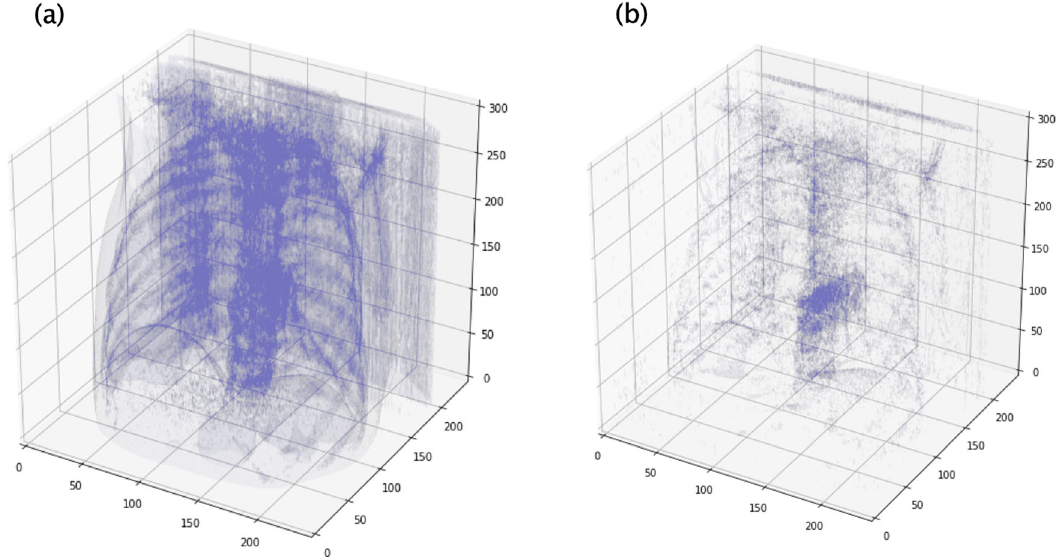
Fig. 3 Schematic representation of BCDU-Net module to detect the infection in CT images. a The original CT images visualized in point cloud. b Reconstructed lung image acquired by feeding the CT slices (Fig. 8 middle part h) into BCDU-Net. The Covid-19 infection area is highlighted in b